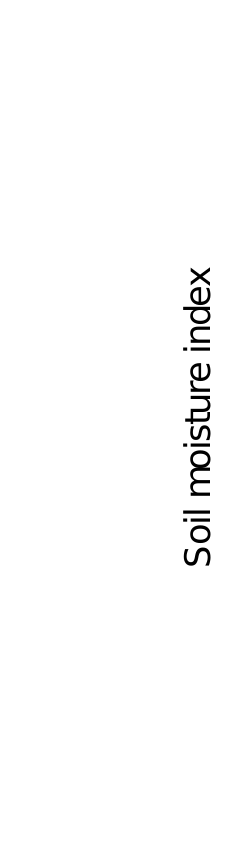
Figure 2. Time sketch showing the evolution of the Soil Moisture Index for a French department (red) in 2014, with climatological